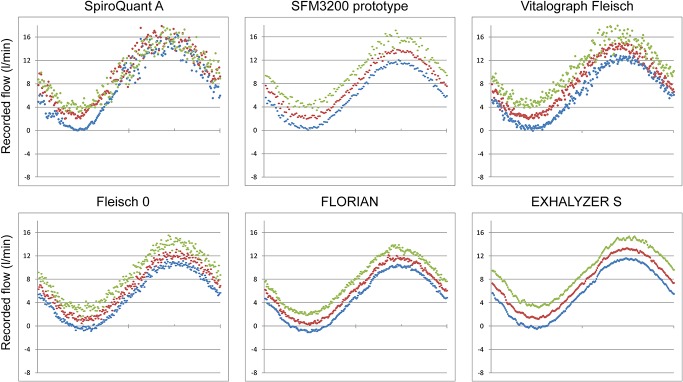
Graphic quality of signal at three levels of CPAP.Recordings from simulations with flow meters connected to the expiratory limb of an Infant Flow device at three levels of CPAP with simulated sinusoidal breathing (32 ml tidal volume, 60 breaths/minute). The colors indicate CPAP level; blue 3.0 cm H2O, red 5.0 cm H2O and green 8.0 cm H2O. The graphs represent one breath (1.0 s).